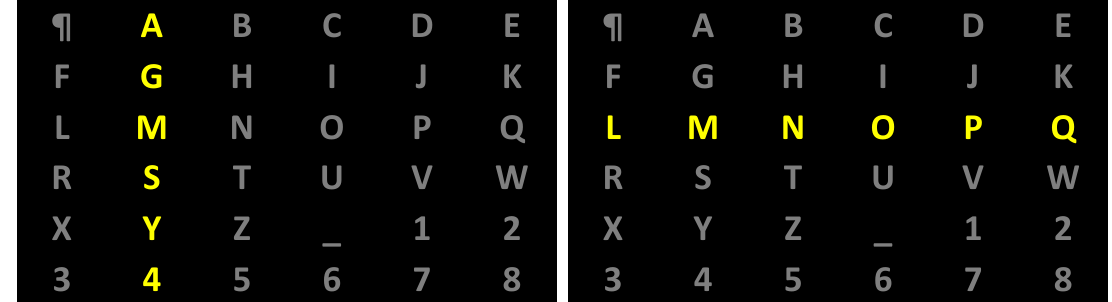
Figure 2. Example of typing matrix in P300-speller. Rows and columns are intensified in random order. The intensification of the second column ( Left panel ) and the third row ( Right panel ) are shown. One round consists of the intensification of each one of the six columns and six